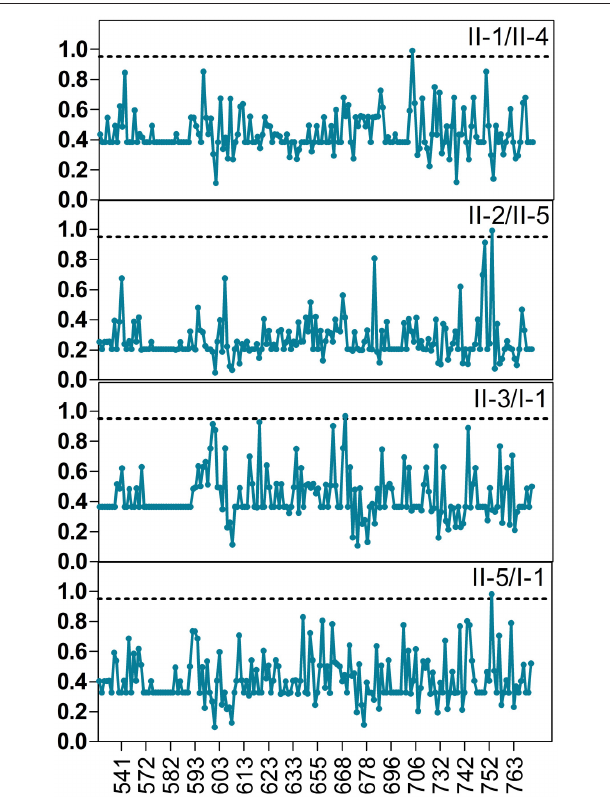
FIGURE 6 | Type I functional divergence among the plant TPS gene members. Posterior probability (PP) profiles of the site-specific type I functional divergence. The line indicates cutoff = 0.95.